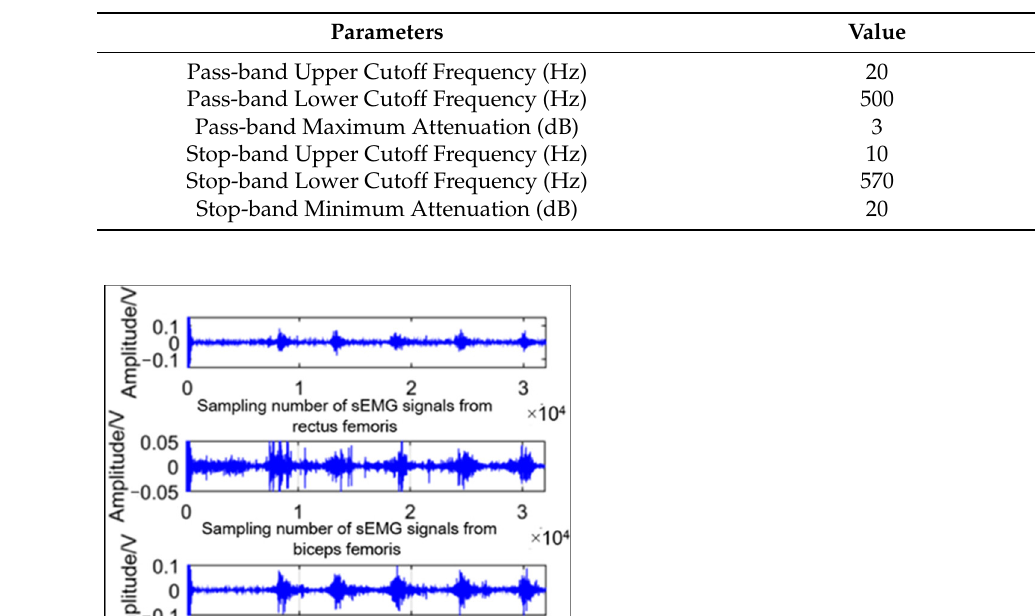
Table 1. Main parameters of band-pass filter.